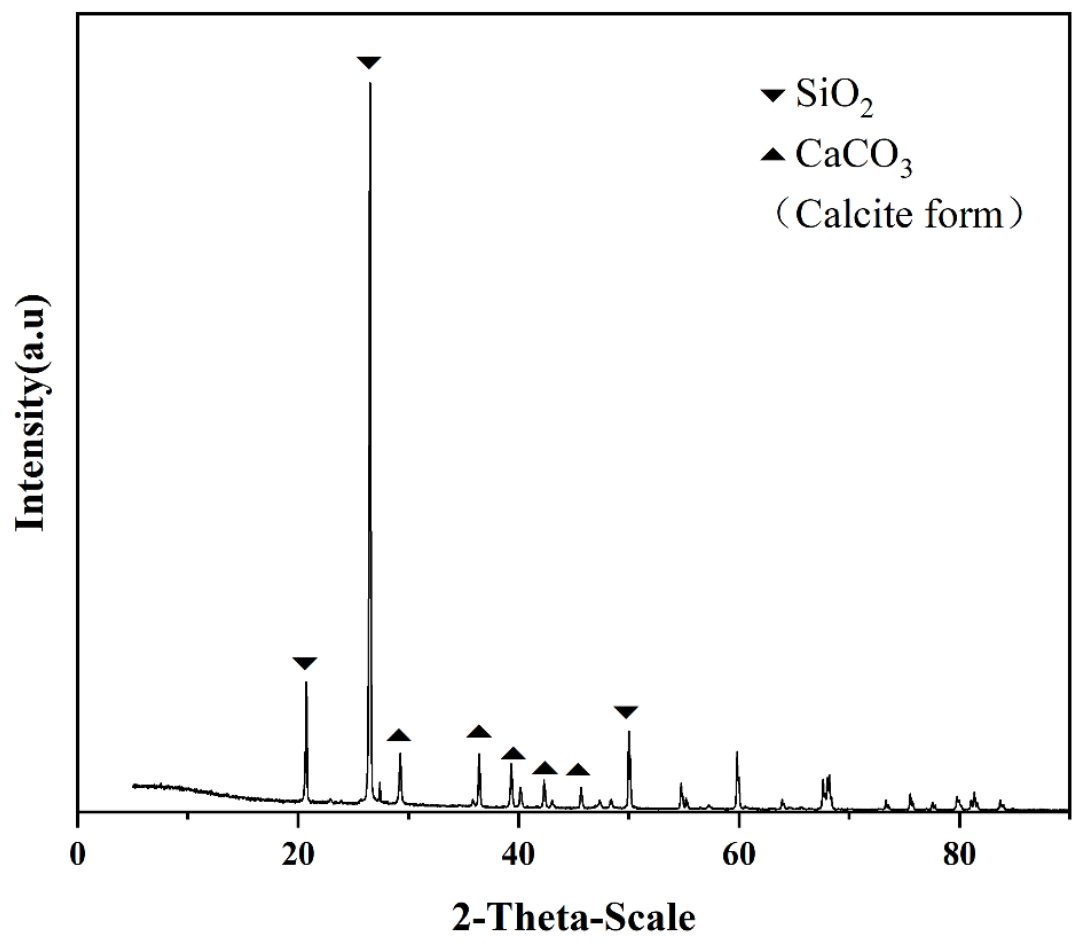
Figure 4. XRD pattern of sand columns after MICP process.